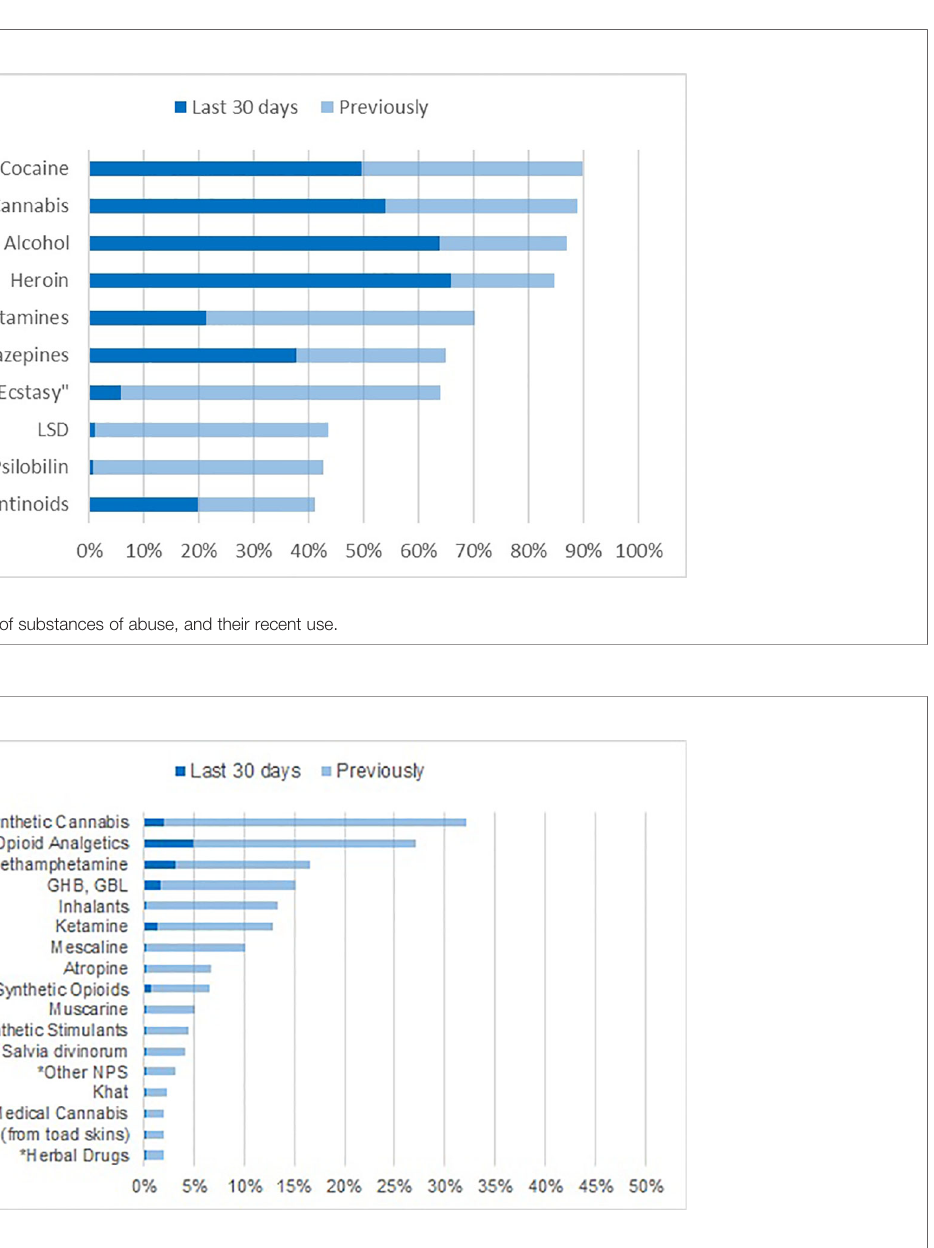
FIGURE 2 | Lifetime prevalence and recent use of other substances including